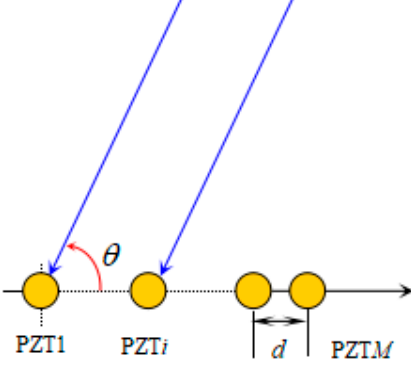
Figure 5. Toeplitz approximation method (TAM) diagram.